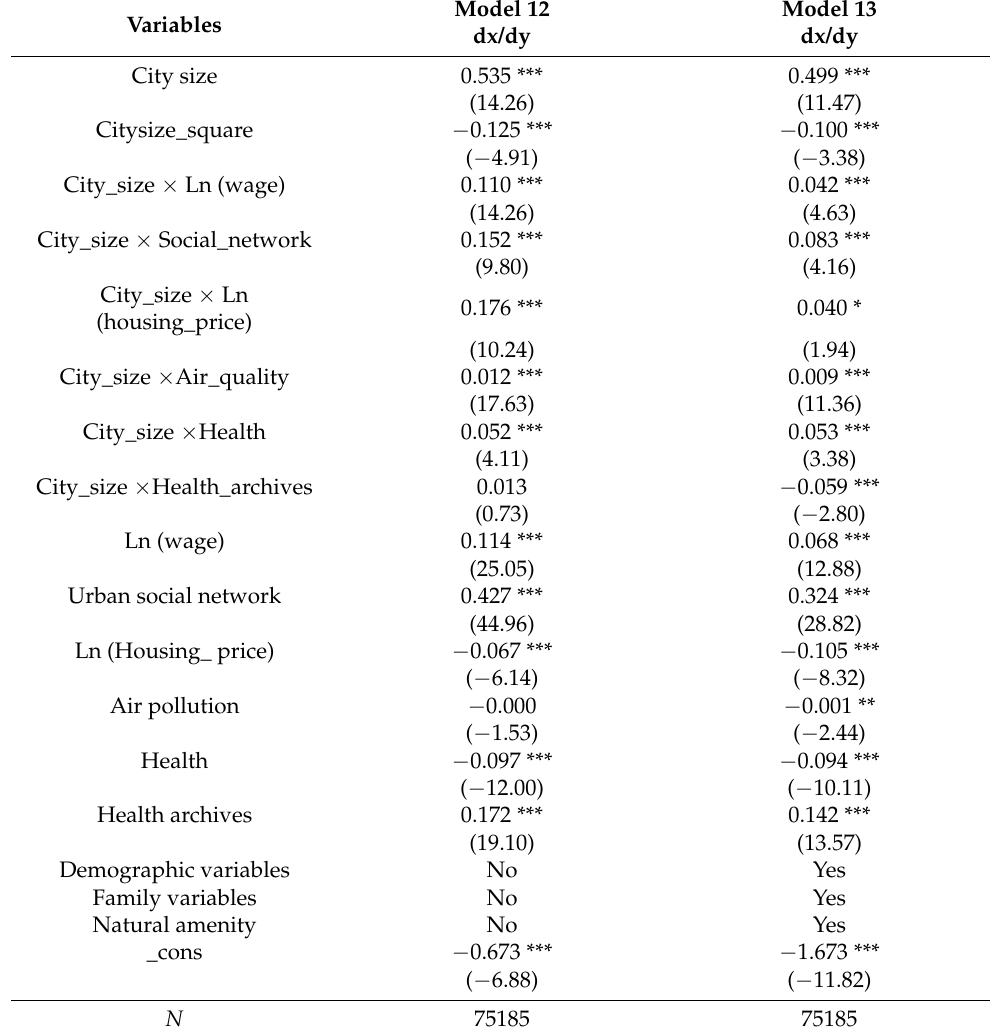
Table 7. The mechanism of city size on urban settlement